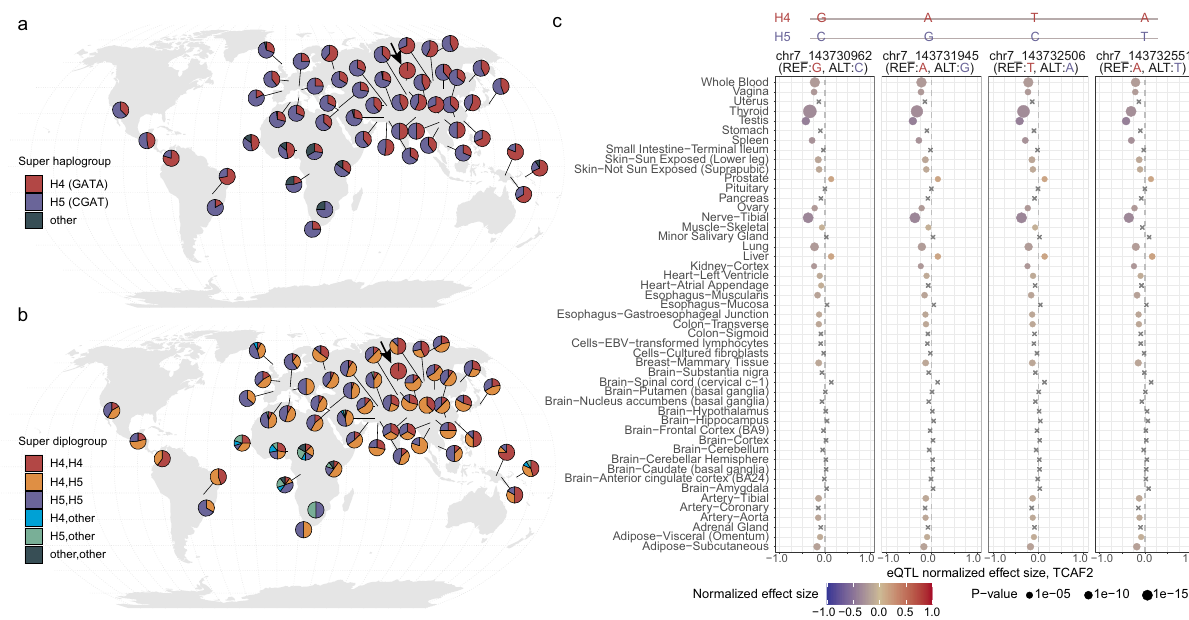
Fig. 6 H4 and H5 super haplogroup distribution and eQTL analysis. Four tagging SNVs were fi rst identi fi ed by perfectly separating super haplogroups H4 and H5 among the seven BAC haplogroups and con fi rmed based on patterns of linkage disequilibrium (LD) in samples from the HGDP panel. a , b Distributions of super haplogroups H4 (red, 57.1%) and H5 (blue, 40.3%) and their diploid type in the HGDP populations across the world. Other haplotypes were found in ~2.6% of the samples. Note that archaic hominin haplotypes from the Neanderthal ( n = 3) and Denisovan ( n = 1) samples all carry H4 haplotypes, and as a representation the geographic location of these samples was placed in the Altai Mountains in Siberia (arrows). These maps were generated using the R packages rgdal (v1.5), scatterpie (v0.1.6), and Natural Earth. c Multi-tissue eQTL plots show consistent patterns of associations between the four tagging SNVs and expression levels of TCAF2 across 50 tissues. Effect sizes were calculated as the effect of the alternative allele (blue) relative to the reference allele (read) as de fi ned in GTEx (release v8) and are scaled using color. The (unadjusted) p values of eQTL association are computed by testing the alternative hypothesis that the slope of a linear regression model between genotype and expression deviates from 0 and represented by dot sizes. Note that crosses (×) indicate insigni fi cant